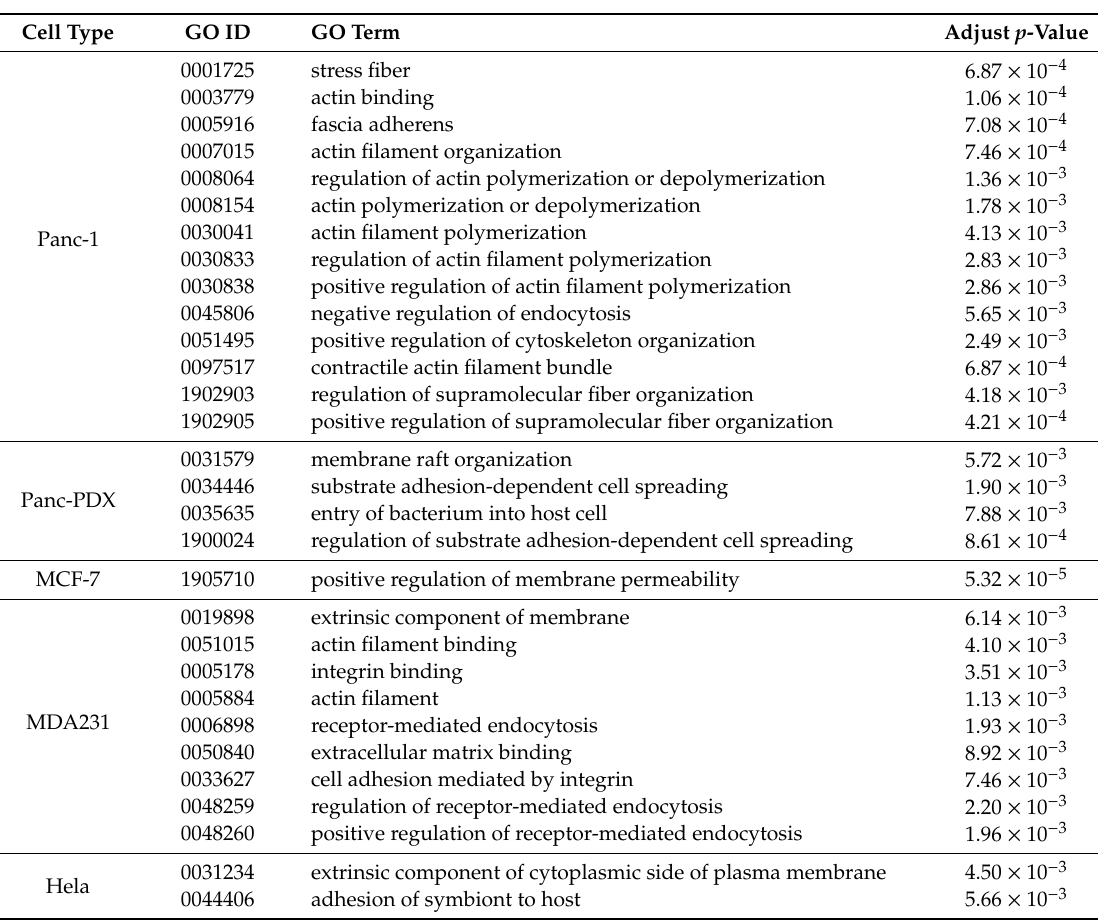
Table 3. Cell membrane associated GO terms unique to each cell